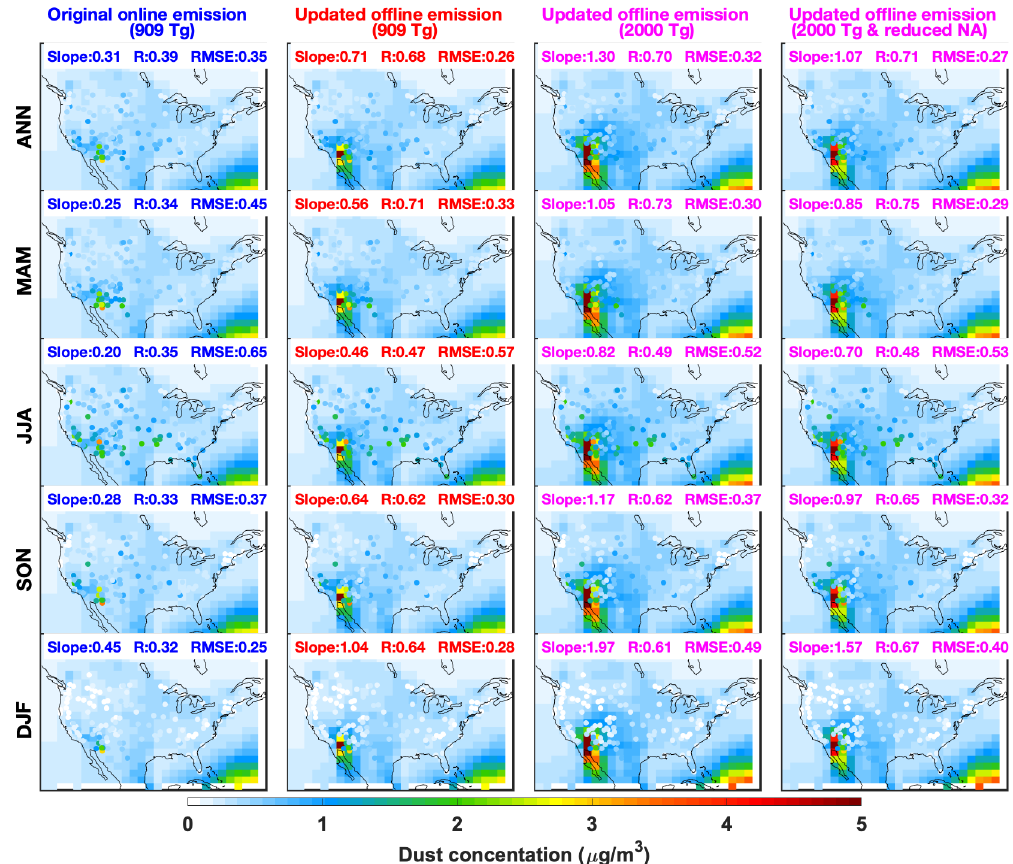
Figure 5. Annual and seasonal mean simulated fine dust concentrations from GEOS-Chem simulations with different dust emissions for 2016, and IMPROVE fine dust measurements, which are shown as filled circles. Root mean square error ( E ), correlation coefficient ( R ) and slope ( M ) calculated with reduced major axis linear regression are reported. The results for the simulation using the original dust emissions are shown in blue (left column). The results for the simulation using updated dust emissions with dust strength of 909Tgyr − 1 are shown in red (second column). The results for the simulation using updated dust emissions with dust strength of 2000Tgyr − 1 are shown in magenta (third column). The right column is the sensitivity simulation with North America dust emission reduced by